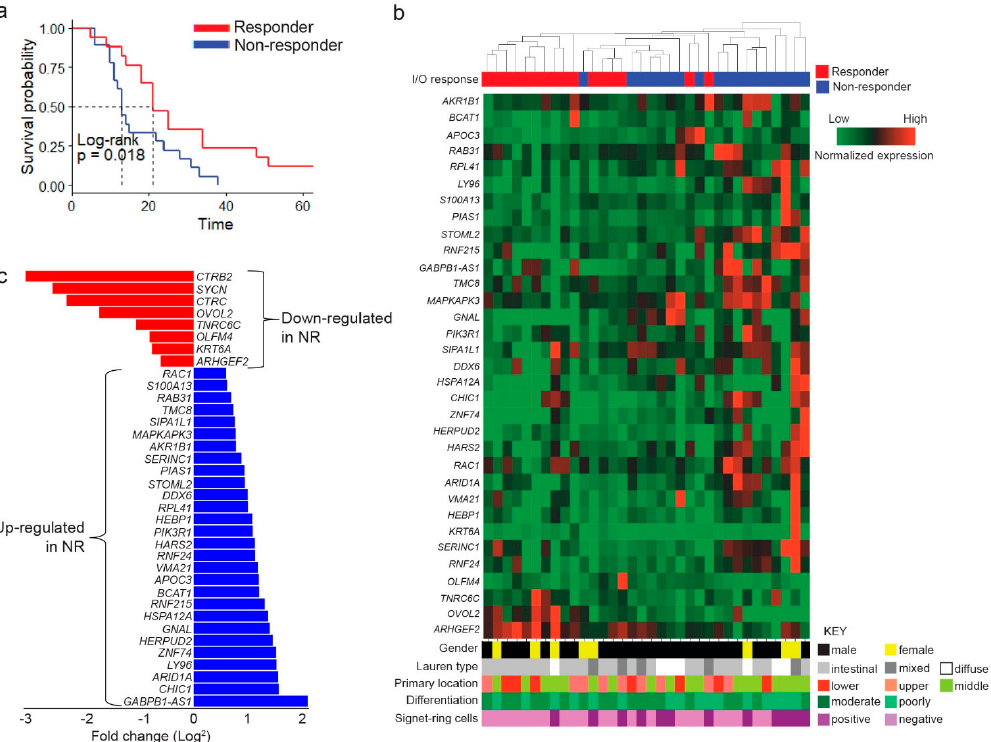
Figure 1. Differentially expressed genes in chemo-immunotherapy responders and non-responders by 3 ′ MACE. ( a ) Kaplan-Meier curve comparing survival rates between advanced GC patients categorized as responders (R) or non-responders (NR) to chemo-immunotherapy (LogRank, p = 0.018). ( b ) Unsupervised clustering of differentially expressed genes analyzed by 3 ′ massive analysis of cDNA ends (3 ′ MACE). The lower panel shows clinical characteristics of patients ( c ) Waterfall plot of differentially expressed genes down-regulated or up-regulated in NR patients.